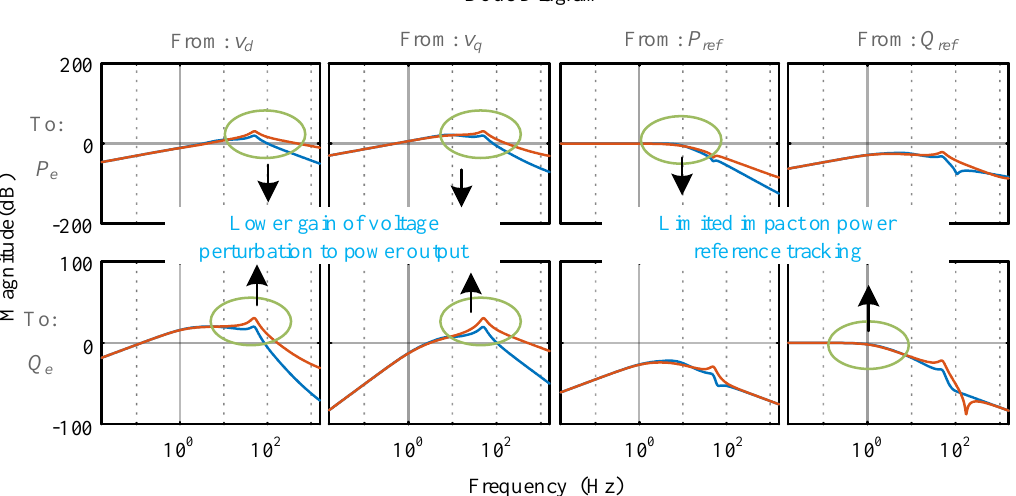
Figure 5. Bode diagram illustrating noise rejection enhancement by adding lowpass filters. Red: without lowpass filters. Blue: with lowpass filters.